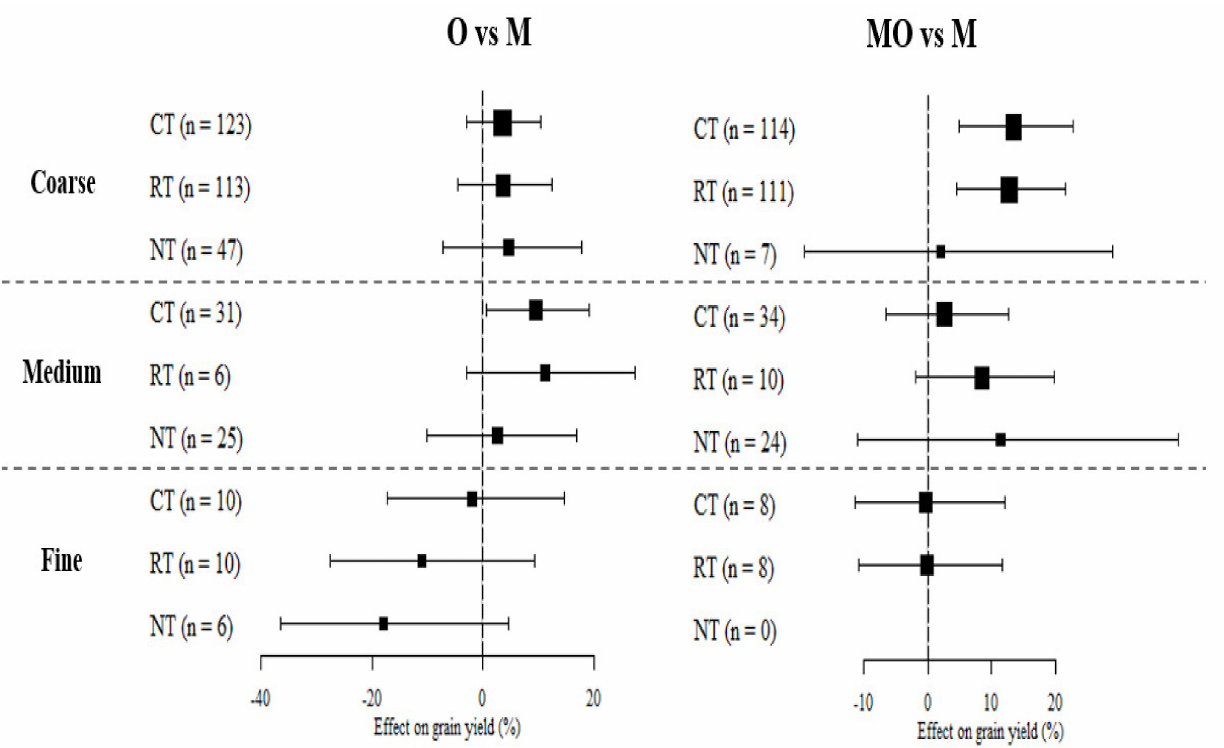
Figure 5. The crop yield response of organic vs. mineral (O vs. M), and mineral + organic vs. mineral (MO vs. M) under conventional, reduced, and no-tillage practices (CT, RT, and NT, respectively) in different soil types, expressed as the average effect on crop yield (%). “n” refers to the number of observations for each subgroup. The vertical line represents the null hypothesis [ ln ( RR ) = 0]. The squares are the point estimate of effect size. The horizontal lines are the associated 95% confidence interval for the population